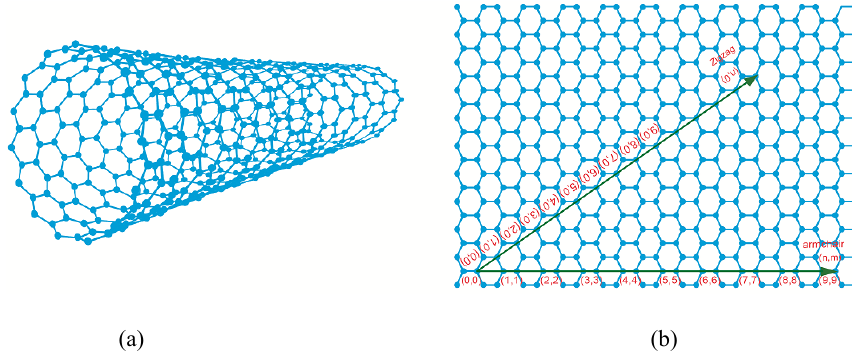
Figure 1. Hexagonal lattice (a) single-walled carbon nanotube (b) graphene sheet.